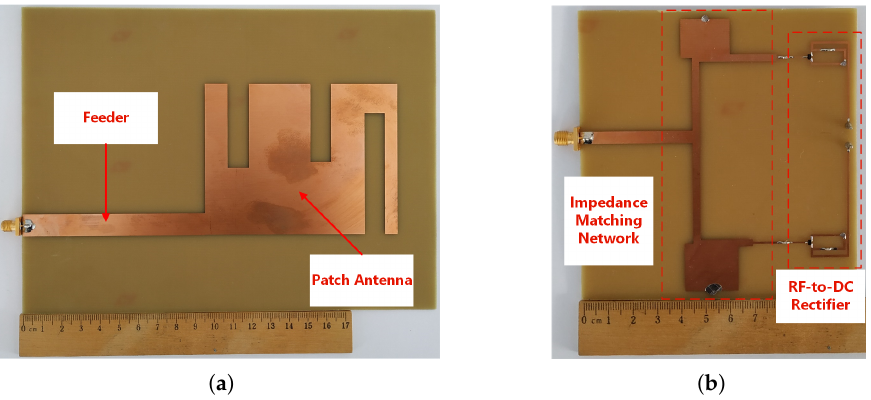
Figure 4. Photograph of the fabricated rectenna prototype (the ground plane is placed on the backside of the rectenna and it is omitted in the photos) ( a ) Proposed antenna and ( b ) Proposed rectifier.